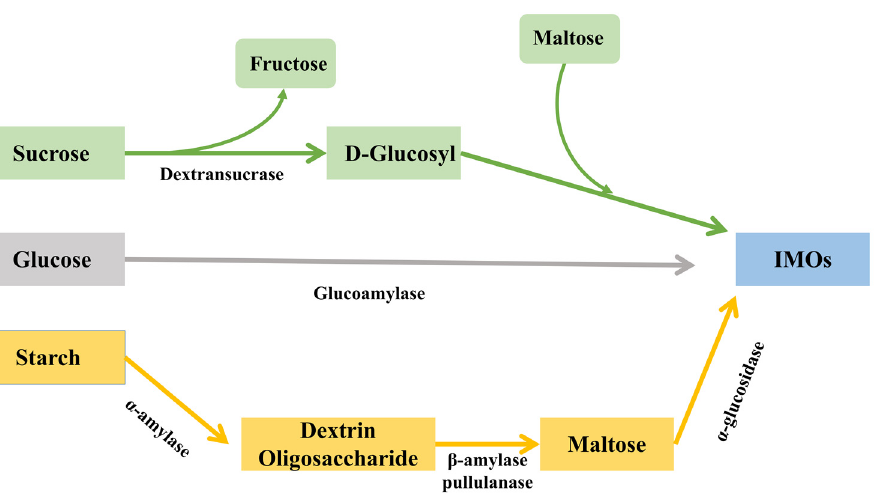
Figure 1. Three main ways for the production of IMOs: Utilizing the retrosynthesis of glucoamylase (grey routine), sucrose and maltose are converted by dextransucrase (green routine), maltose catalyzed by α -glucosidase (yellow routine).